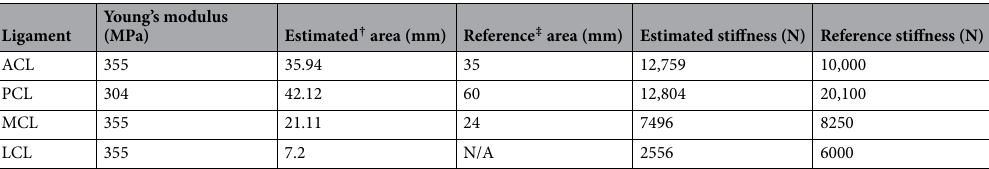
† The estimated values ‡ As “reference” we denote the values that are